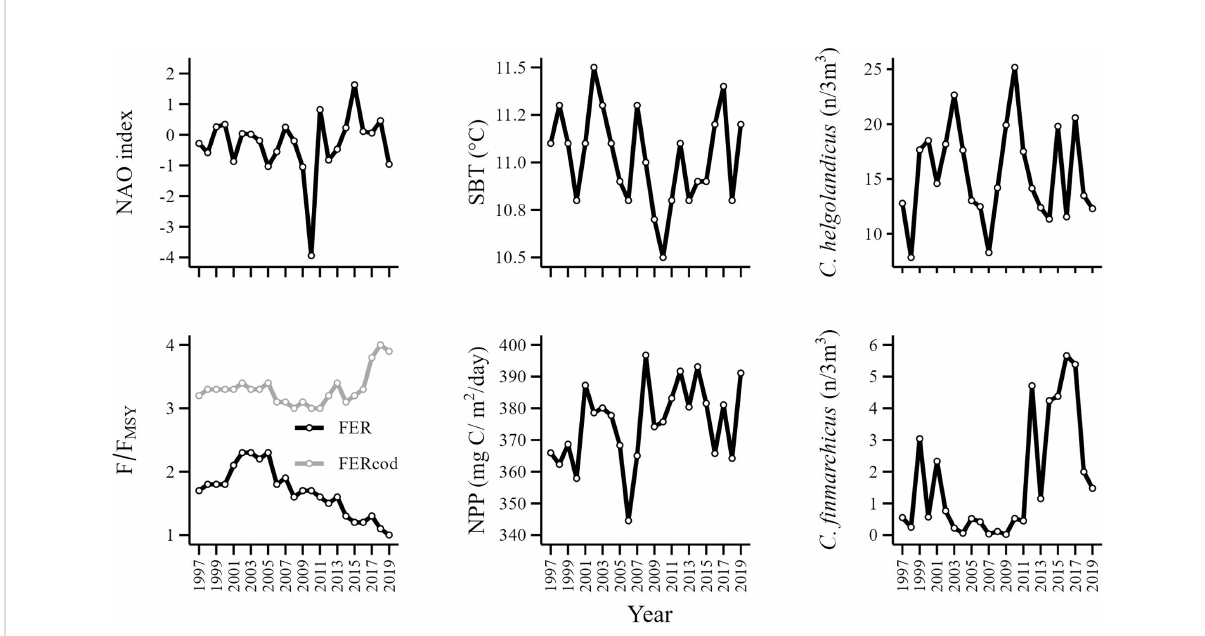
FIGURE 4 Time series of explanatory variables. Catch weighted mean fi shing exploitation rate (FER), cod exploitation rate (FERcod), North Atlantic Oscillation index (NAO), net primary production (NPP), sea bottom temperature (SBT) and the relative abundance of C. fi nmarchicus (FIN) and C. helgolandicus